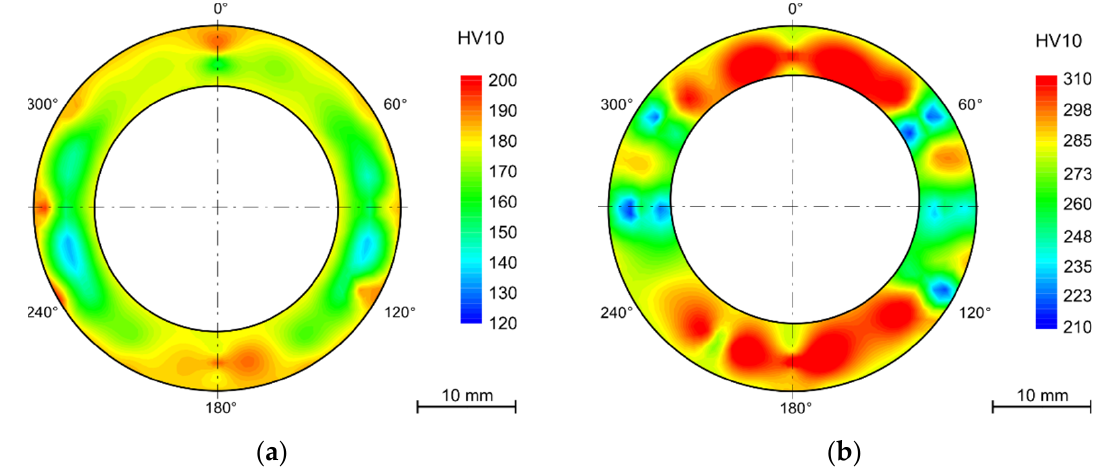
Figure 5. ( a ) As-received (solution annealing 2 min); ( b ) as-received after bending, without HT. The solution annealing after bending lead to the hardness increase of 80–100 HV10 in tension- and compression-stressed fibers and a decrease of approximately 50 HV10 in the neutral axis (Figure 6). This process eliminated the influence of the bending process and restored the as-received structure with average hardness of 180 HV10. The variation of hardness between the outer and inner diameters was also eliminated.